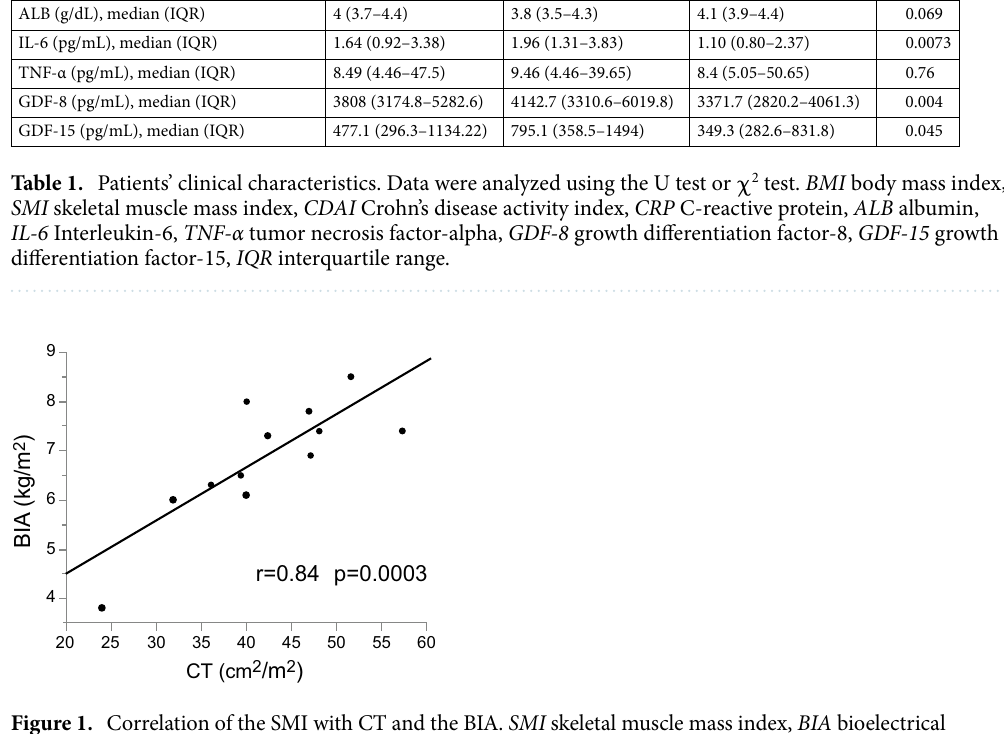
Figure 1. Correlation of the SMI with CT and the BIA. SMI skeletal muscle mass index, BIA bioelectrical impedance analysis, CT computed